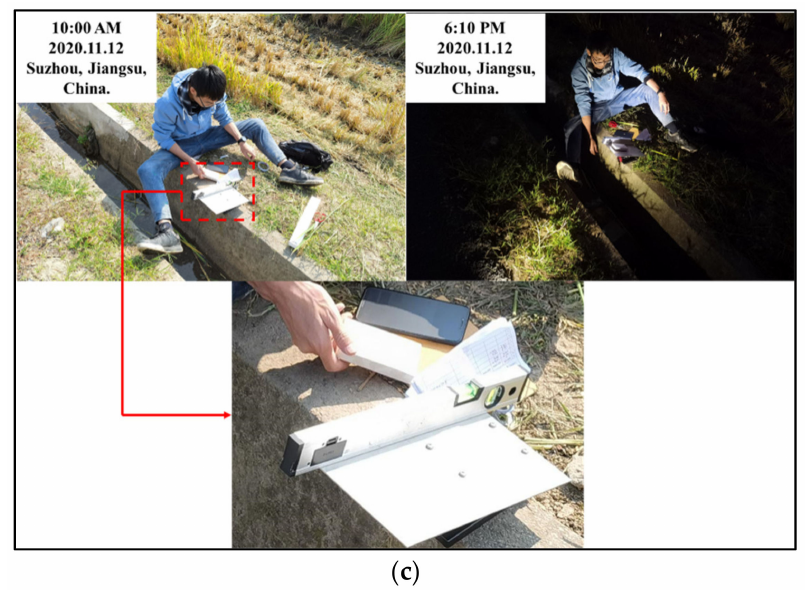
Figure 3. Measurement process of the friction coefficient: ( a ) angle measuring device; ( b ) measuring principle; ( c ) measurement site.